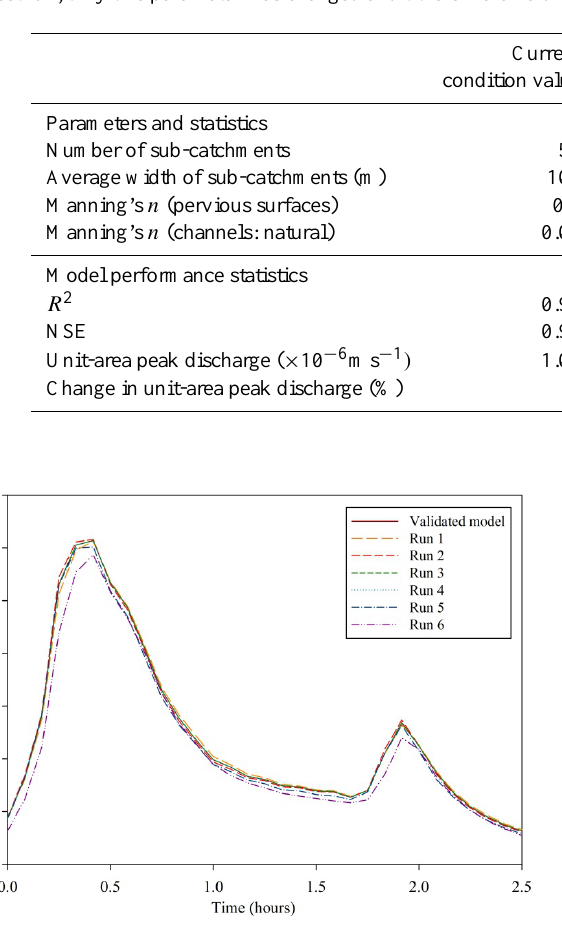
Table 6. Uncertainty analyses for variations in sub-catchment width and Manning’s n (impervious surface and natural channels) for WS4. In each test run, only one parameter was changed and others were held constant.